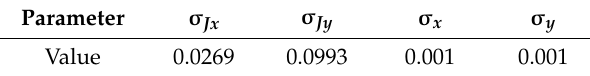
Table 5. Statistical parameters for Kalman filter.